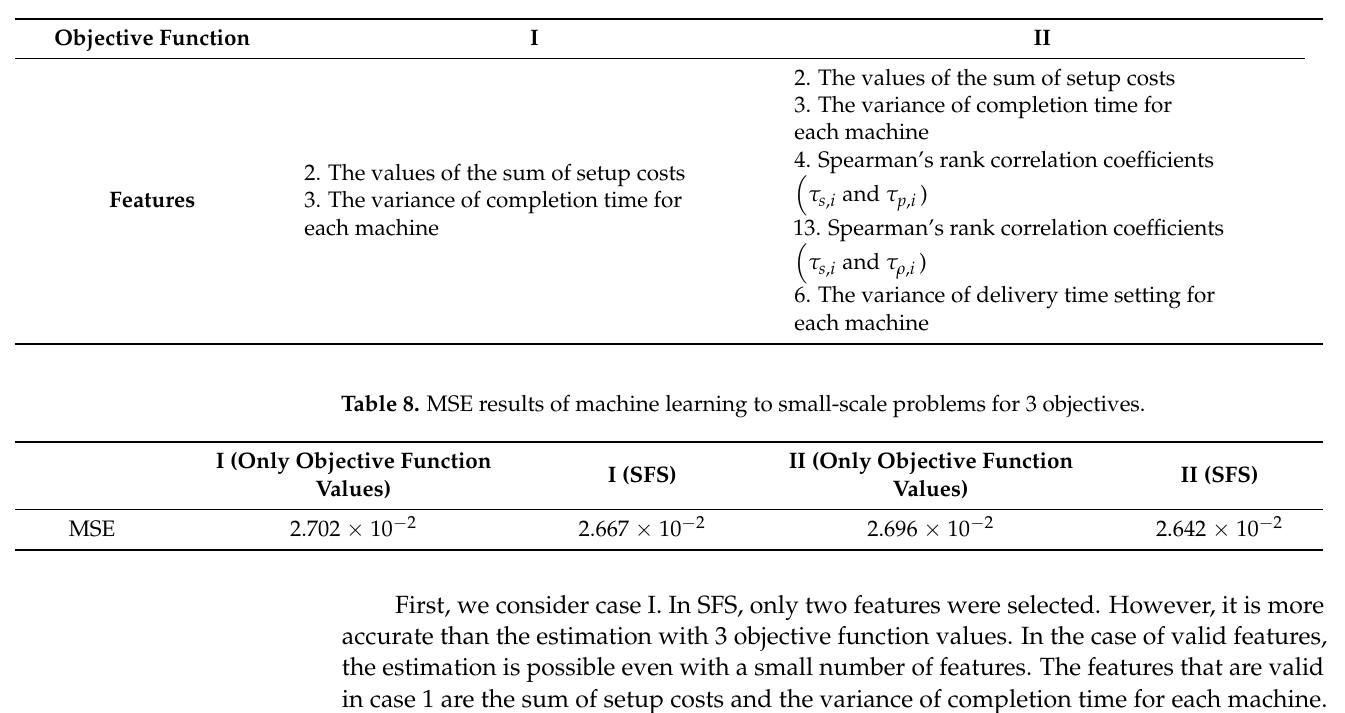
Table 7. List of features selected by SFS small-scale problems for 3 objectives.